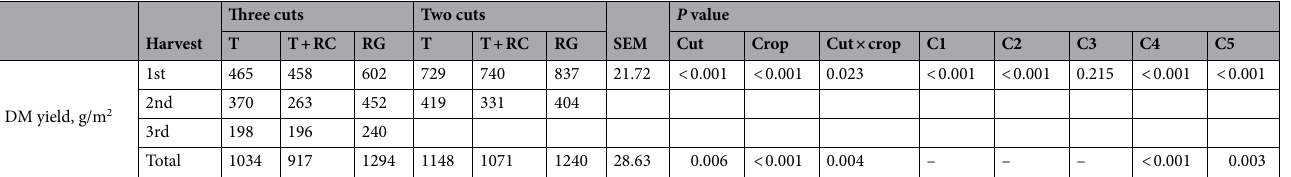
Table 1. Effect of Cut (1–5 where 1,3 and 5 is the first, second and third cut in the three-cut system, and 2 and 4 is the first and second cut in the two-cut system, respectively) and crop (T, timothy; T + RC, timothy + red clover; RG, perennial ryegrass) on dry matter yield per cut and total annual yield (n = 3). SEM is the standard error of the means. C1 is the contrast three versus two cuts per season, overall; C2 is the contrast three versus two cuts per season in the 1st cut; C3 is the contrast three versus two cuts per season in the 2nd cut; C4 is the contrast T versus RG; C5 is contrast T versus T +